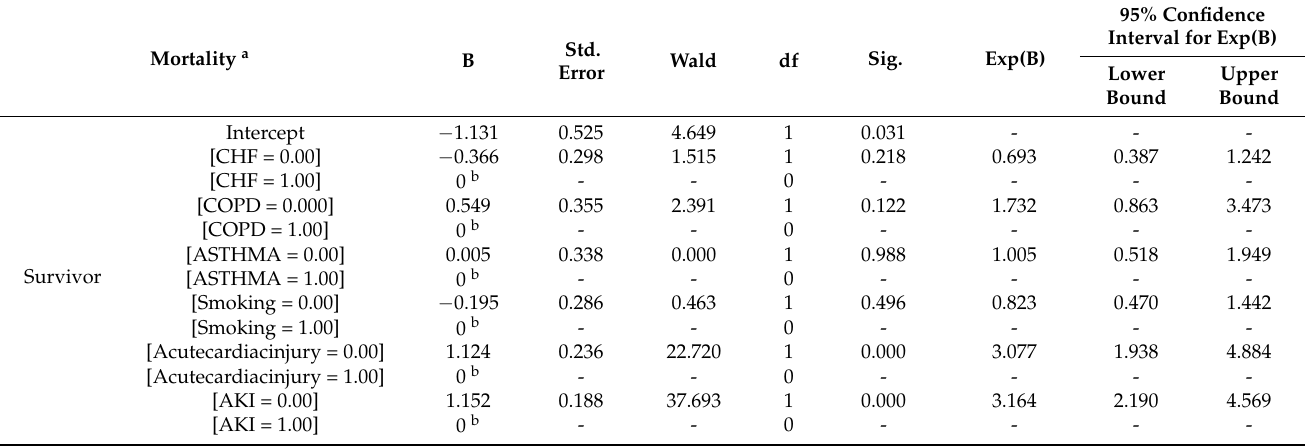
Table 5. Parameter estimates.